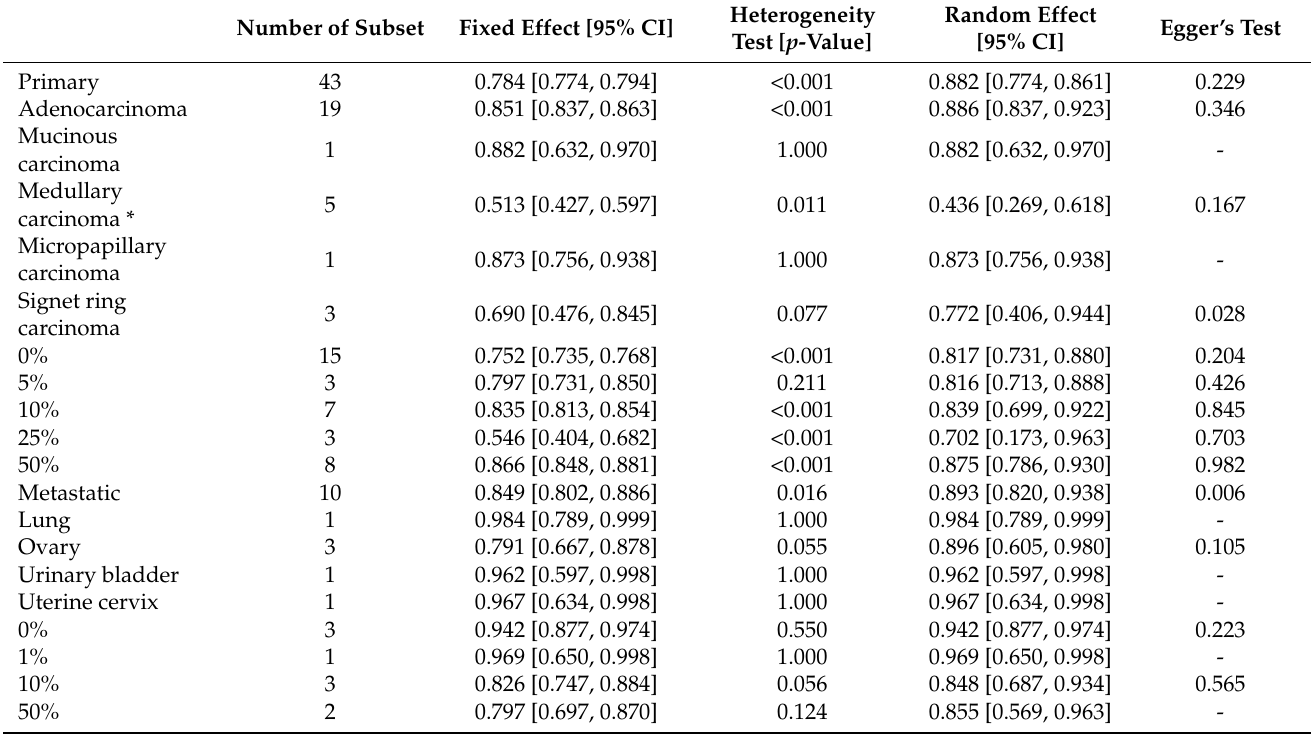
Table 2. Meta-analysis for the CDX2 expression rate in the primary and metastatic colorectal